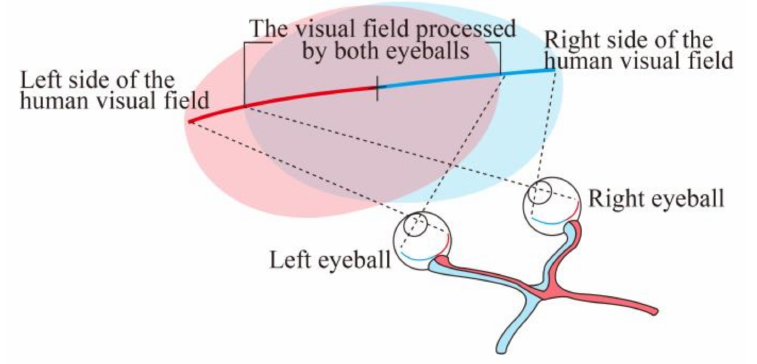
Figure 1. Visual field and the processing retinae in the human